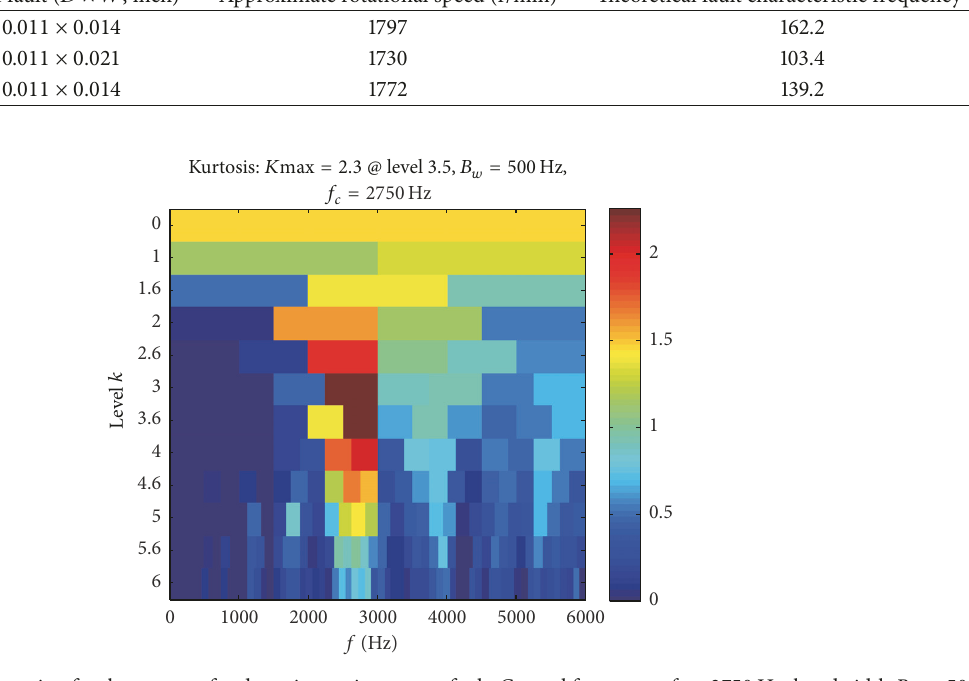
Figure 8: Processed results using fast kurtogram for detecting an inner race fault. Central frequency 𝑓 𝑐 = 2750 Hz, bandwidth 𝐵 𝑤 = 500 Hz, and level 𝑘 = 3.5